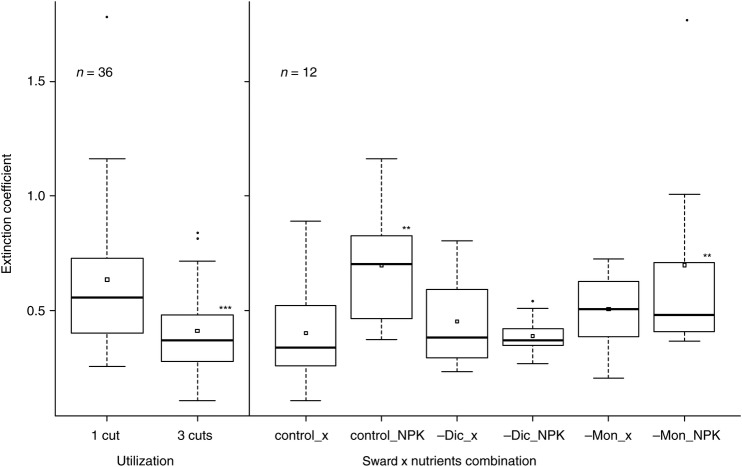
Extinction coefficient in the different experimental treatments in July 2009. Asterisks denote significant differences of factor levels compared with the reference level (sward control, utilization 1/year, control_ x). Interaction sward × nutrients (F(2, 49) = 3.30, P = 0.045).